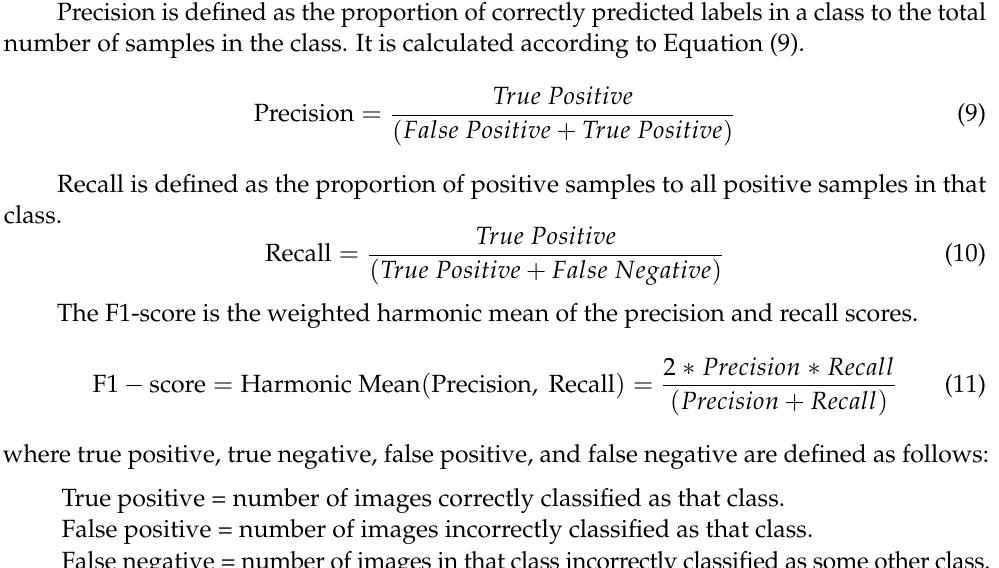
Figure 10. The 4-class classification model that takes the weighted frequency array for the images and trains the model to classify the images into one of the 4 classes as normal, benign, in situ, and invasive.